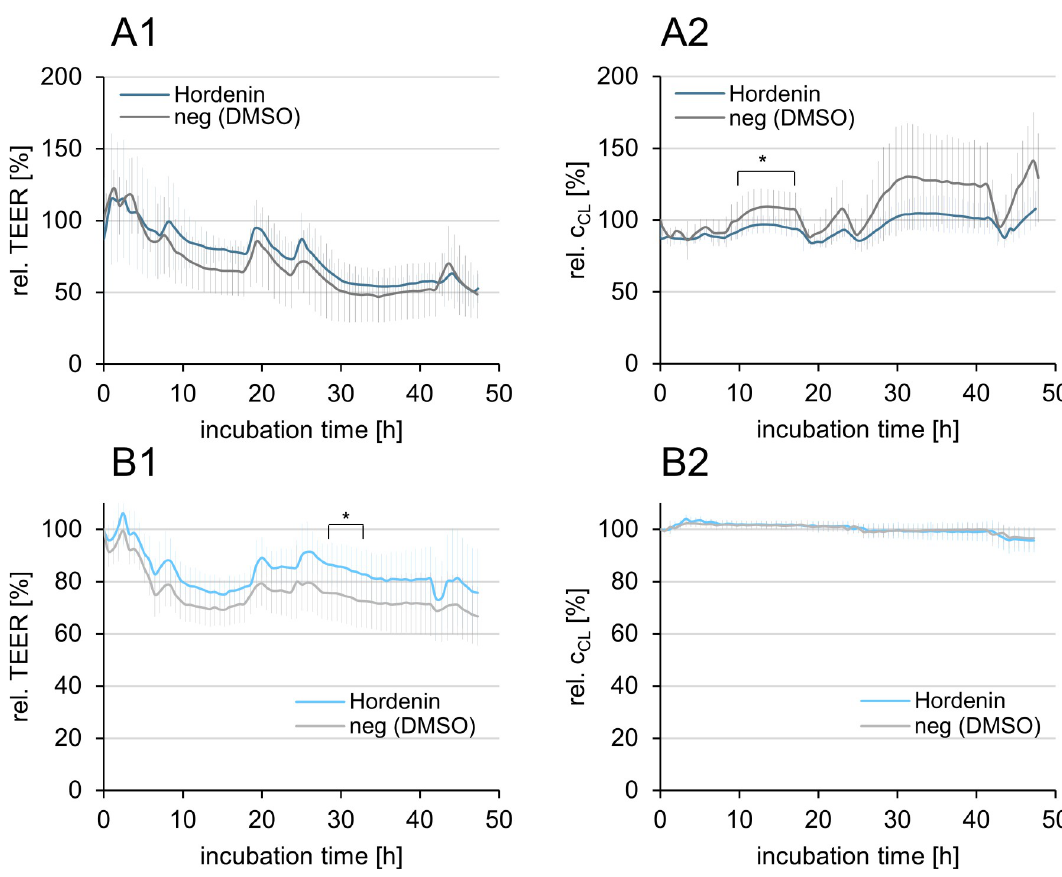
Fig 3. Relative transepithelial/transendothelial electrical resistance (TEER) and electrical capacitance ( c CL, ) of Caco-2 cells (A1/ A2) and primary porcine brain capillary endothelial cells (PBCEC, B1/B2) incubated with 1 μ M hordenine or solvent (neg, 0.1% DMSO) for 48 h ( n = 3 × 3). The data are normalized to the initial values at the beginning of the transport studies and represented as means ± standard deviations. Significant differences ( p < 0.05) between the test substances and the respective negative control were calculated in the Student’s t -test and marked with asterisks.